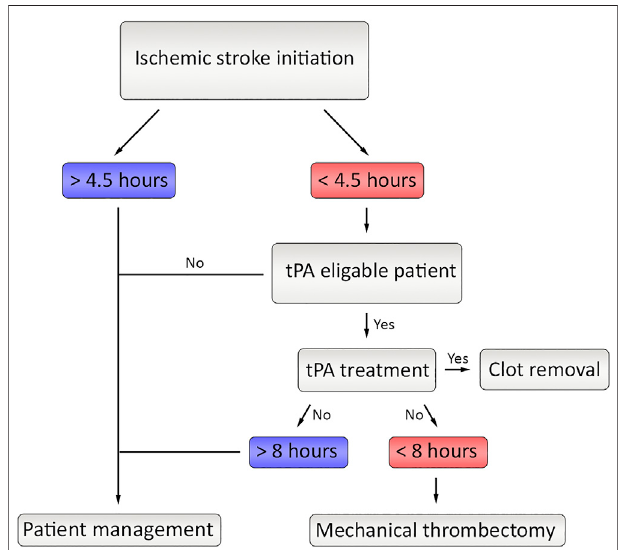
FIGURE 4 | The current fl ow of therapeutic approaches in ischemic stroke. After initiation of the stroke, if the time limit is under 4.5 h and if tPA is eligible, the tPA treatment is applied. If the clot is still not fully removed and if the time did not exceed 8 h, Mechanical thrombectomy could be